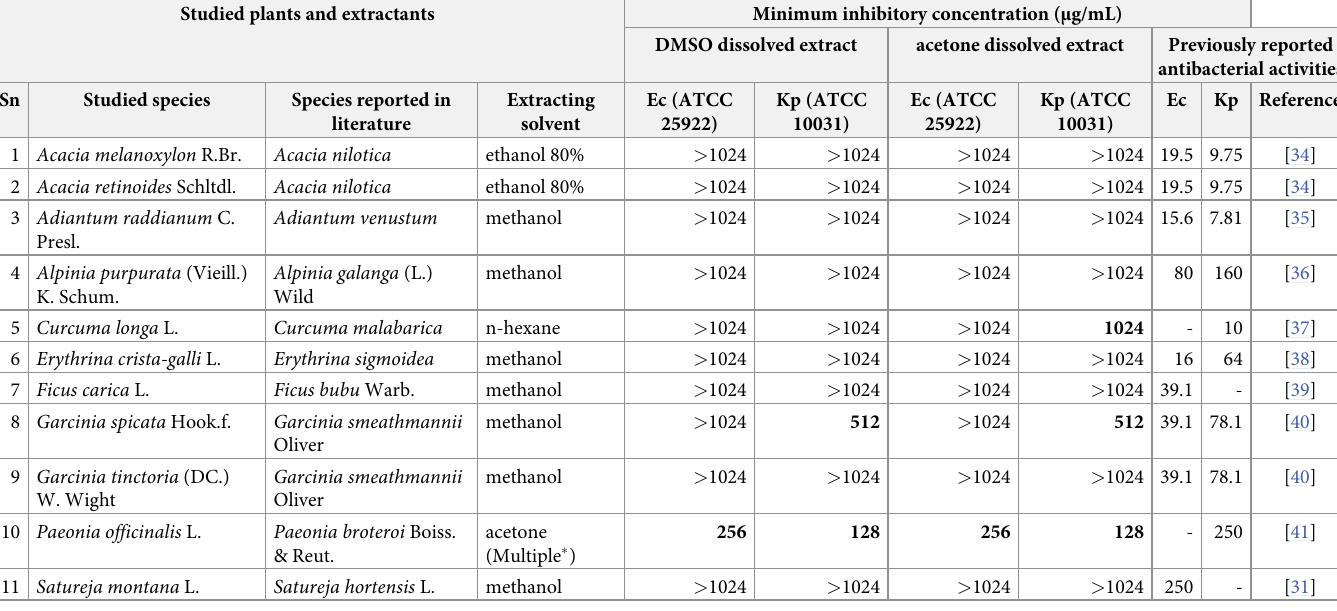
Table 3. Minimum inhibitory concentrations (MICs) of 10% DMSO and acetone dissolved extracts of plant species reported to those reported in the literature. Studied plants and